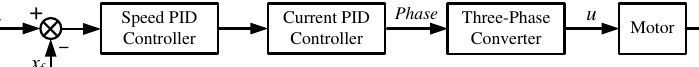
Figure 7. Simulation structure of FPID controller.